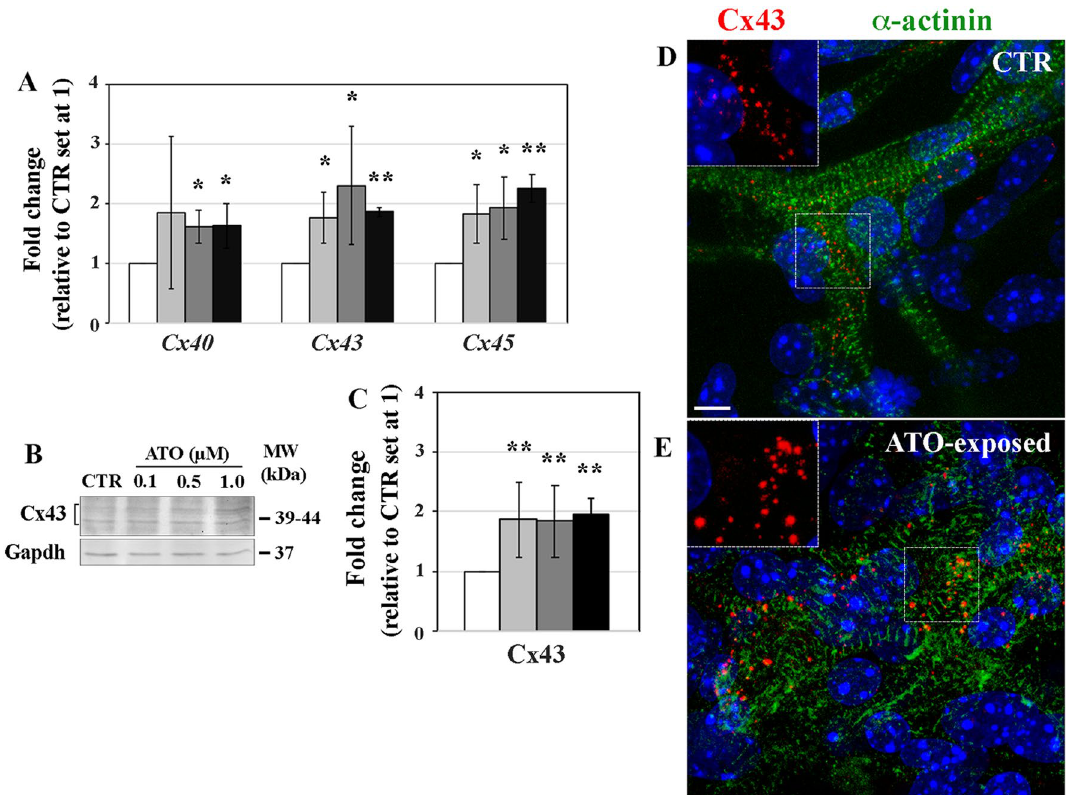
Figure 6. Expression profile of genes coding for the major connexin isotypes of control (CTR) and ATO- treated cardiomyocytes ( A ). Western blotting analysis of Connexin 43 (Cx43) protein ( B ) and its quantitation ( C ). * p < 0.05; ** p < 0.001. Whole mount immunofluorescence localization of Cx43 (magnification in the inset) and of α-actinin proteins in CTR ( D ) and in 1.0 µM ATO-exposed ( E ) cardiomyocytes. Nuclei are stained with DAPI (blue). Bar: 5